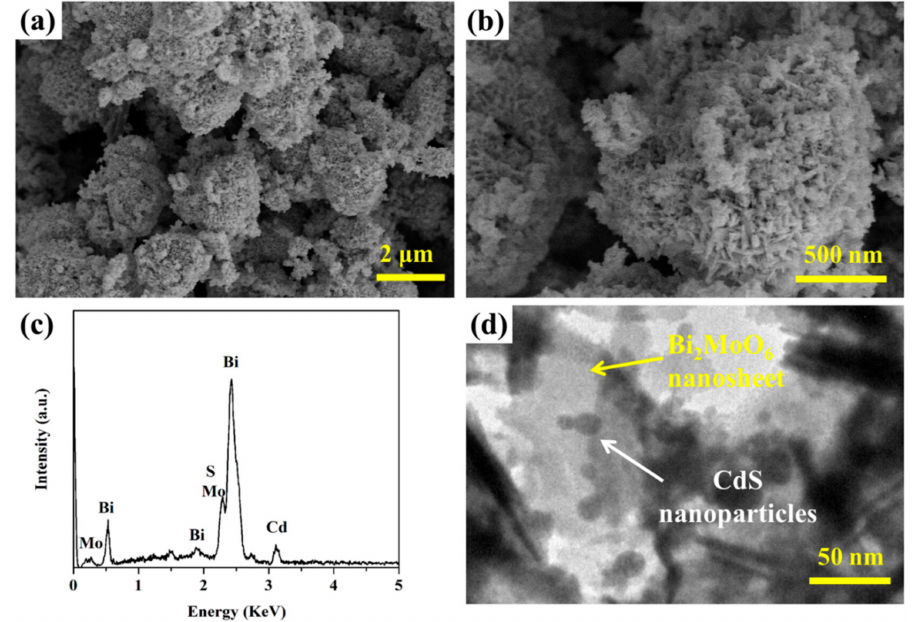
Figure 2. ( a , b ) SEM images, ( c ) EDX spectrum, and ( d ) TEM image of 1.0CdS/Bi 2 MoO 6.